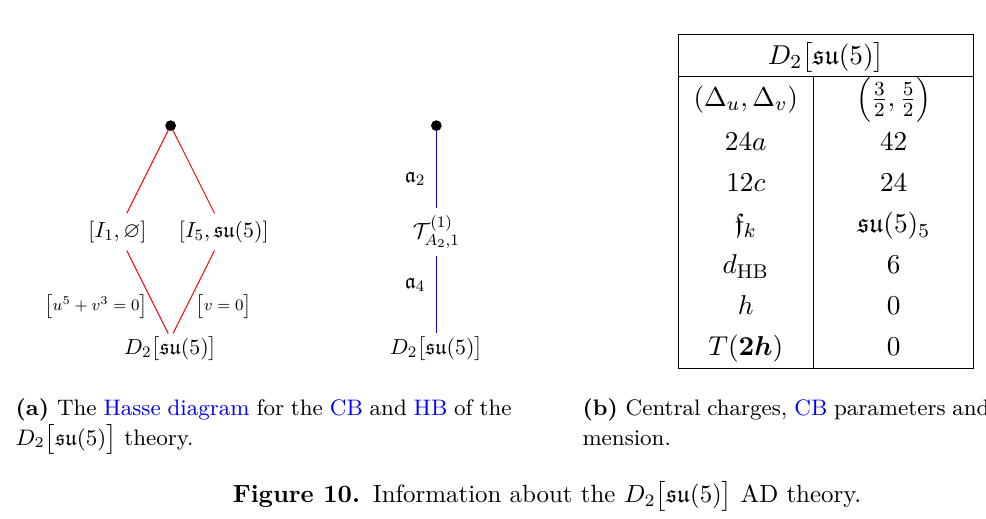
Figure 10. Information about the D 2